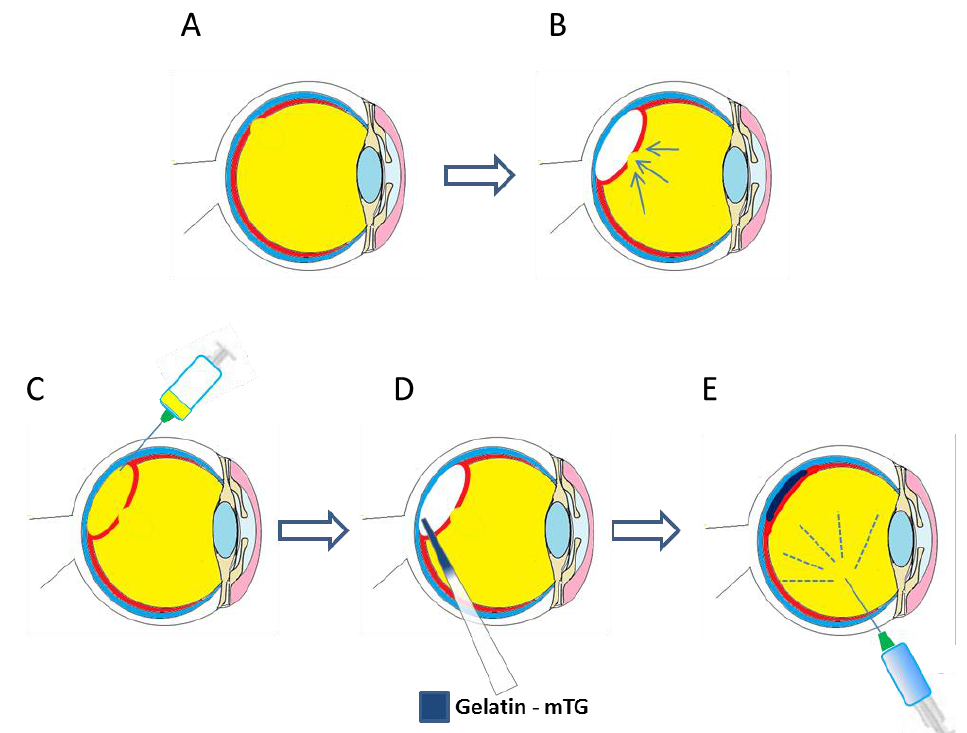
Figure 5. Potential treatments of retinal tears with m-TG. ( A ) Retinal tear initially forms; ( B ) if large enough vitreous humor diffuses into sub-retinal space exacerbating the tear and forcing more retinal tissue away from the RPE; ( C ) sub-retinal vitreous humor aspirated; ( D ) a homogenous mixture of gelatin and m-TG solutions mixed and applied to the sub-retinal space; ( E ) normal ocular pressure restored through infusion of vitreous replacement